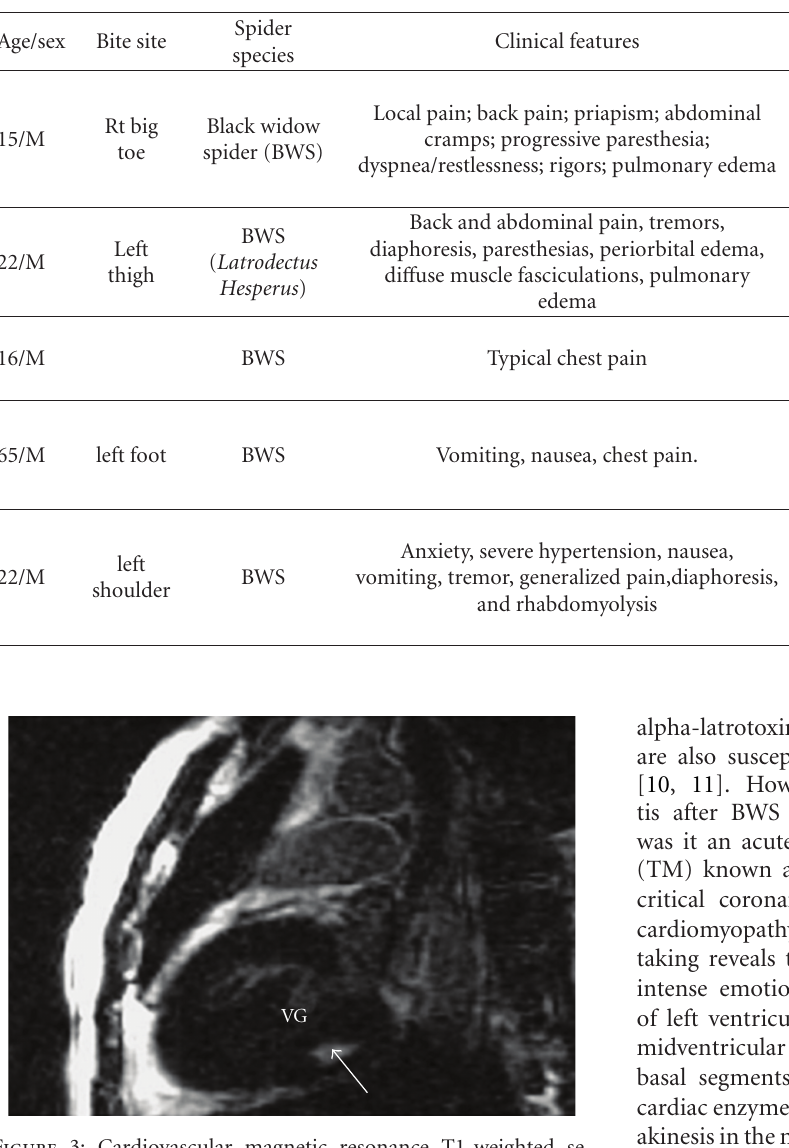
Figure 3: Cardiovascular magnetic resonance T1-weighted se- quence obtained two weeks after discharge showed hyperintensity of the posterior lateral wall of the basal left ventricle. LVEF was